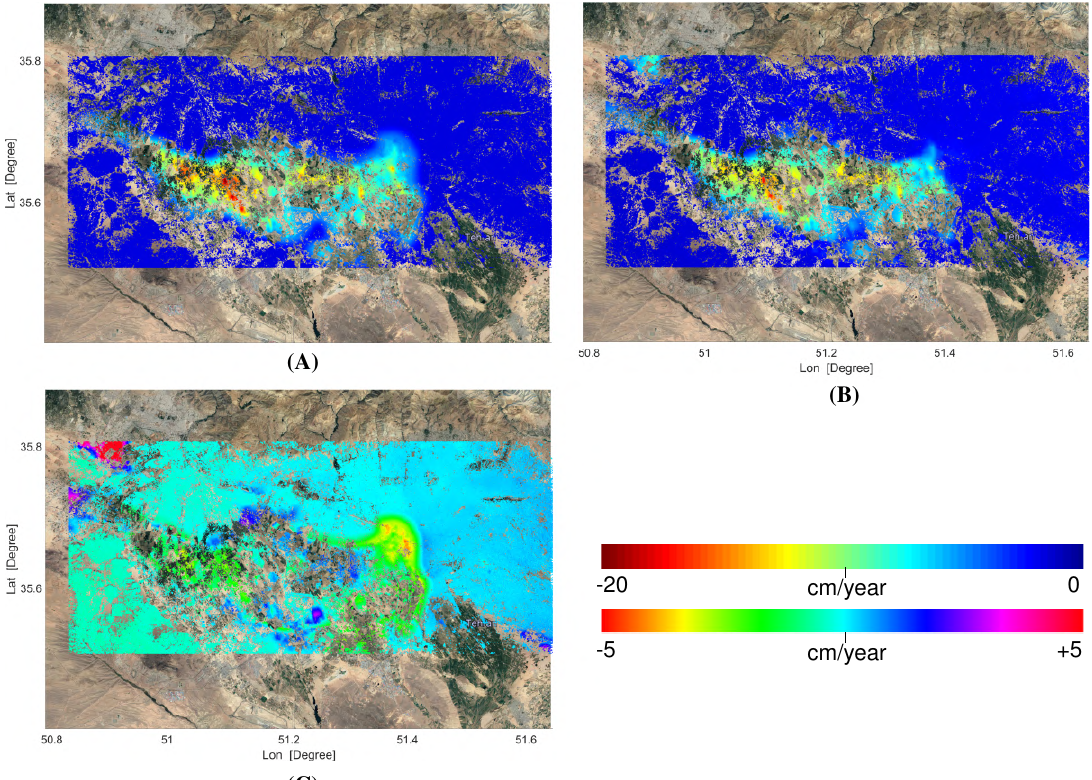
Figure 7. Tehran basin subsidence with Semi-SBAS method in ascending orbit. A) prior information. B) Tehran basin subsidence in ascending orbit. C) The difference between A and